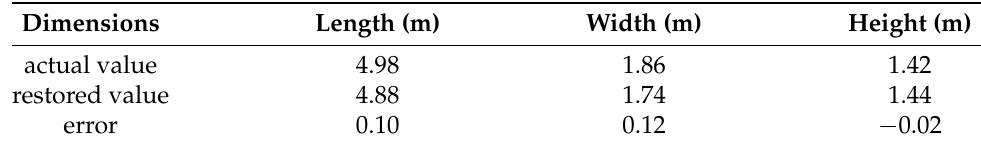
Table 1. Quantitative evaluation of vehicle C.